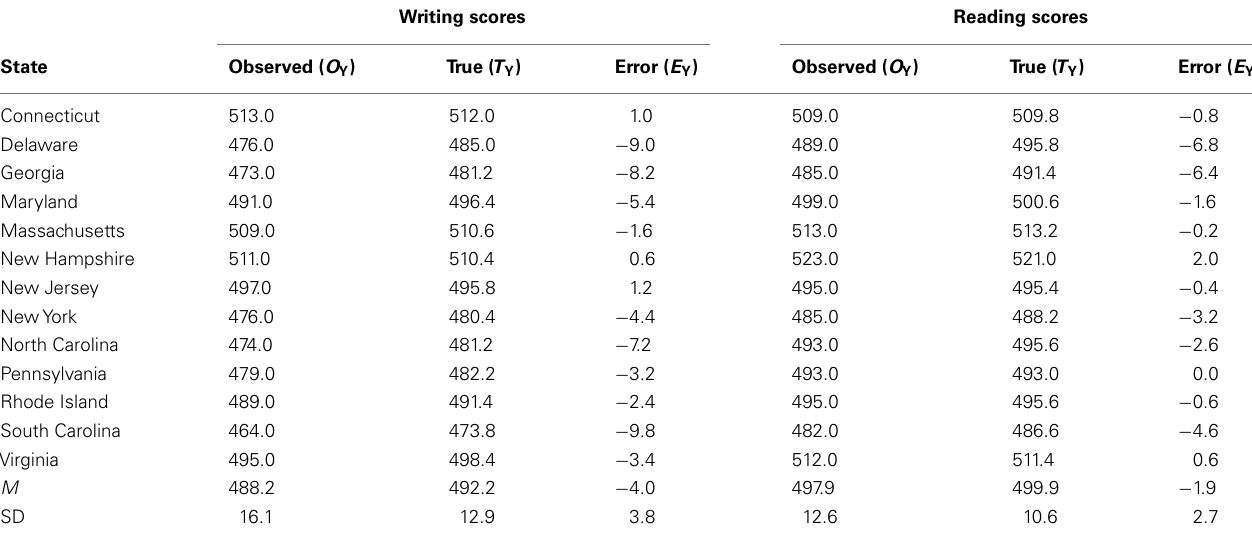
Table 1 | SAT data observed, error, and true